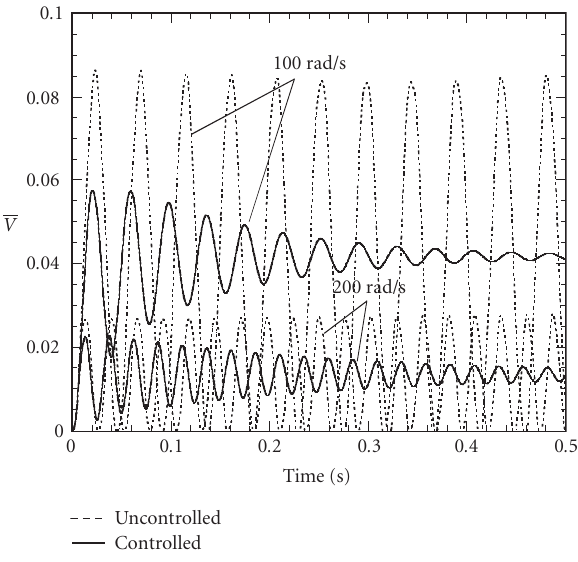
Figure 18: Influence of the rotating speed on the uncontrolled/con- trolled flapping nondimensional deflection time-history to the step loading with σ = 1, β o = γ = 0, and θ = 60deg.